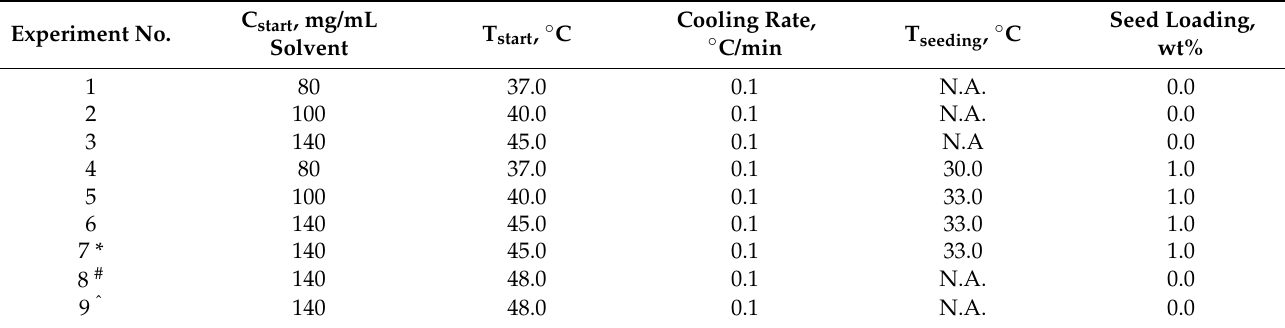
Table 1. Experimental conditions of crystallization.